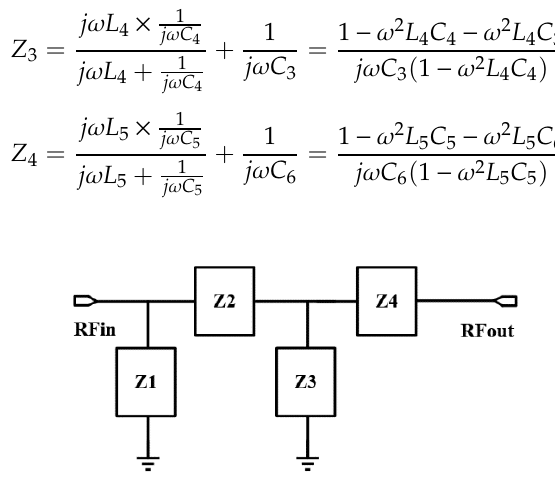
Figure 6. Simplified Z-model of the proposed